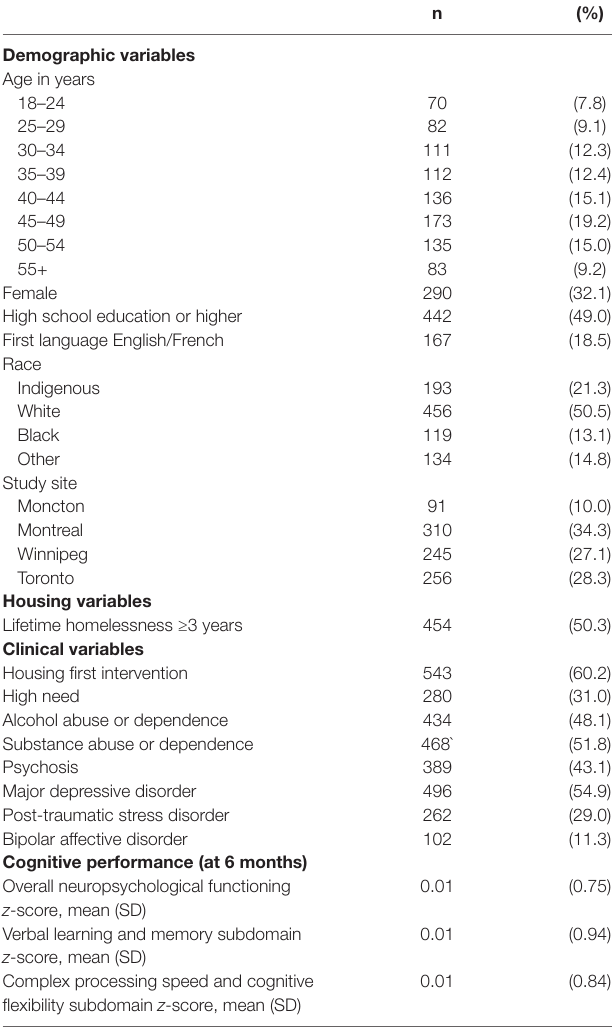
TABle 1 | Baseline sample characteristics (n =